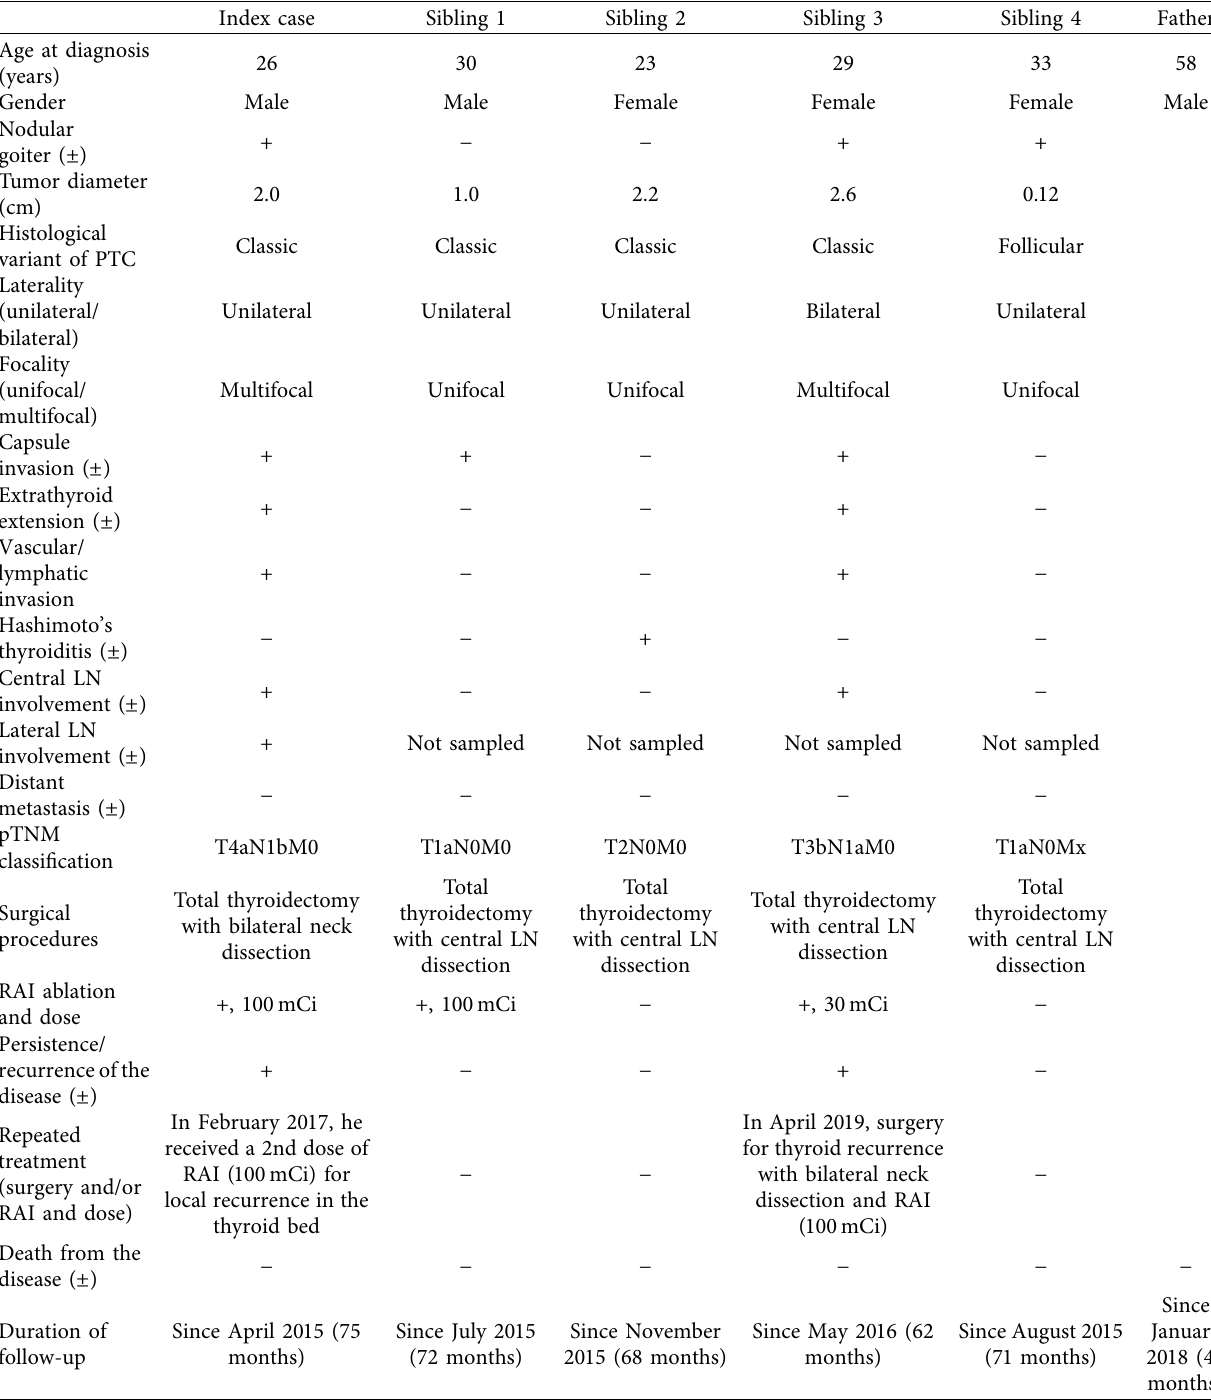
Table 1: Characteristics of the diagnosed thyroid cancer in the family